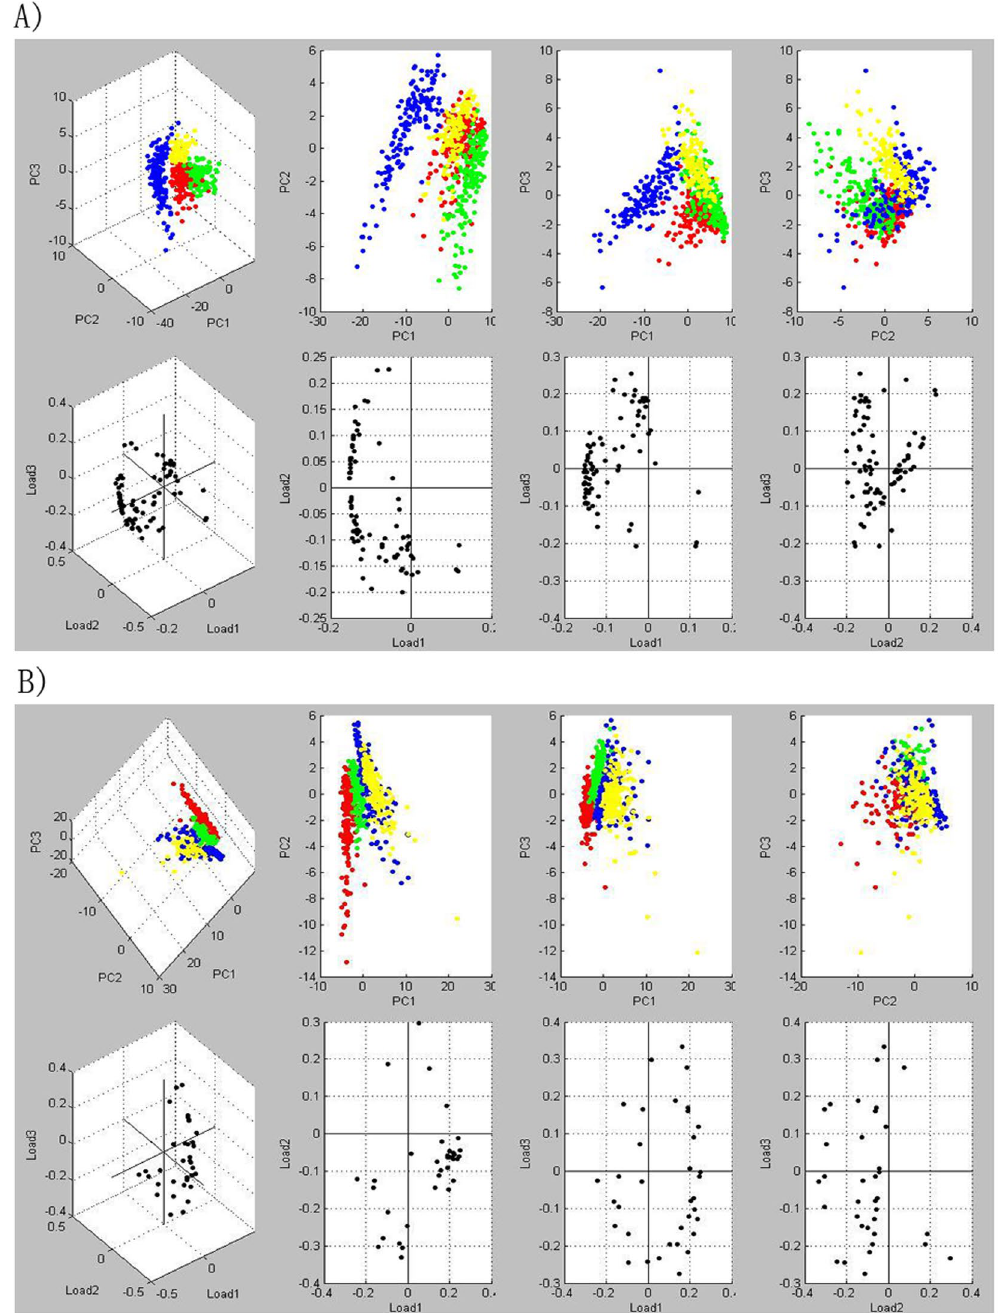
Figure 4. Principal component analysis (PCA) of MALDI IMS data acquired in the liver samples at 0 h (red), 48 h (green), 96 h (blue), 144 h (yellow) postmortem. ( A ) In SD rat liver samples; ( B ) in human liver